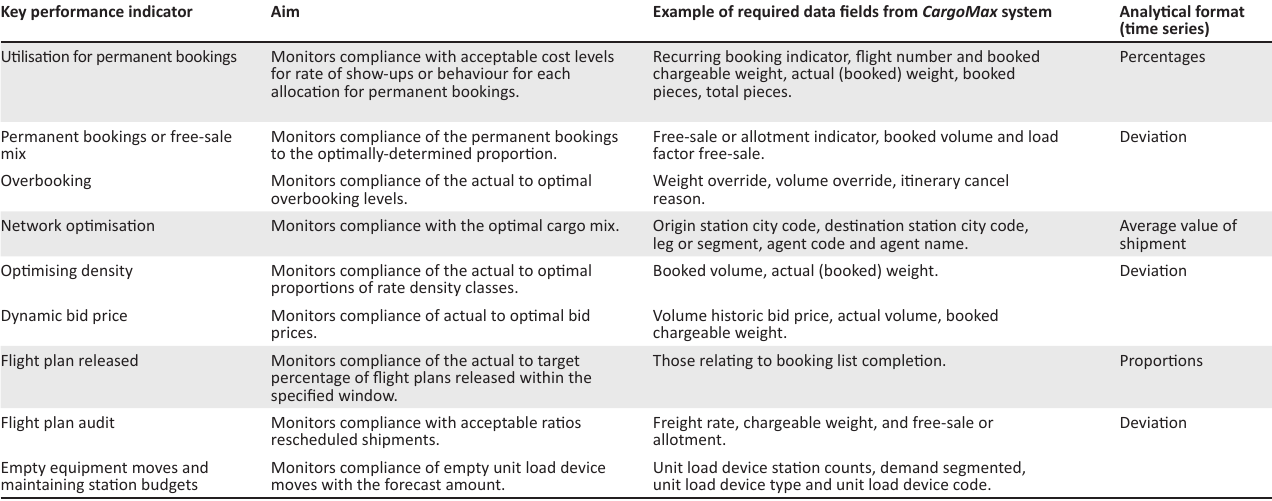
TABLE 1: Key performance indicator